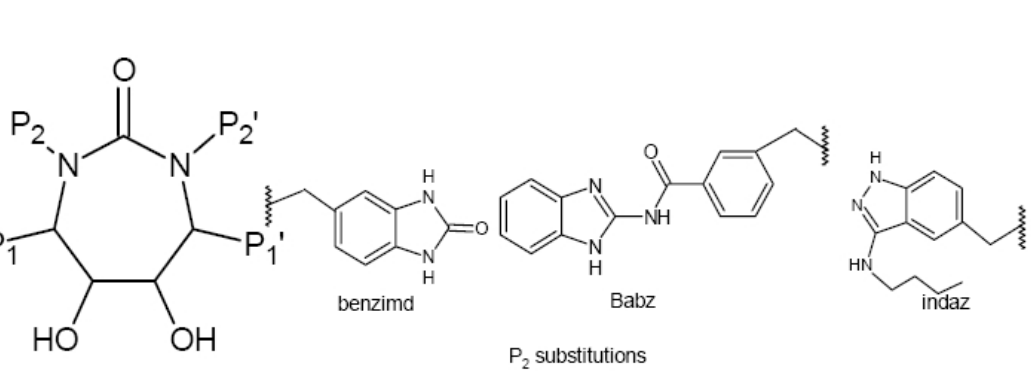
Fig. 1 Structures of known cyclic urea inhibitors with P 2 substitutions, other P 2 and P 1 substitutions given in Table